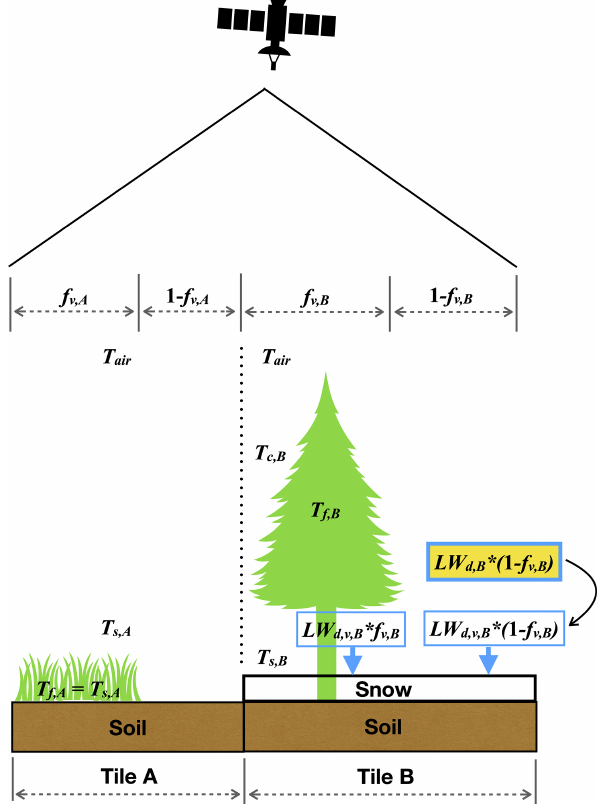
Figure 2. Schematic explaining how LST is computed in VIC (LST V ) as compared to MODIS (LST M ) in a pixel covered by short vegetation (tile A) and tall trees (tile B). f v is the vege- tation fraction, T air is the air temperature, T s , T f , and T c are simu- lated temperatures for the surface, canopy, and canopy air, LW d , v is the downward longwave radiation from the canopy, and LW d is the downward longwave radiation from the atmosphere. The subscripts A and B refer to the variables in each